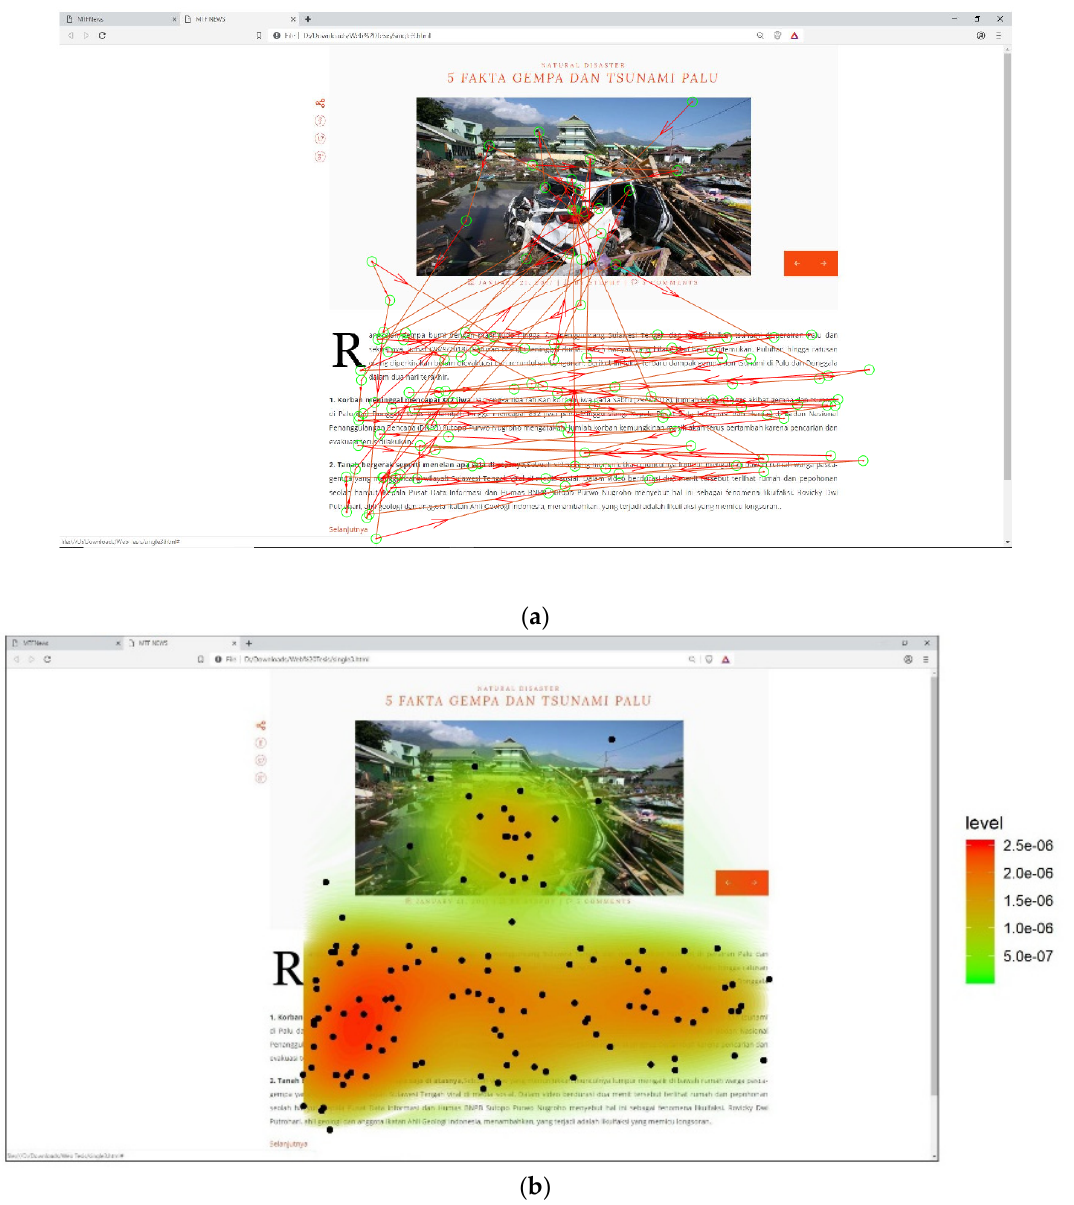
Figure 4. (a). Example of gaze plot of low anxiety; (b) example of heat map of low anxiety. Figure 4. ( a ) Example of gaze plot of low anxiety; ( b ) example of heat map of low